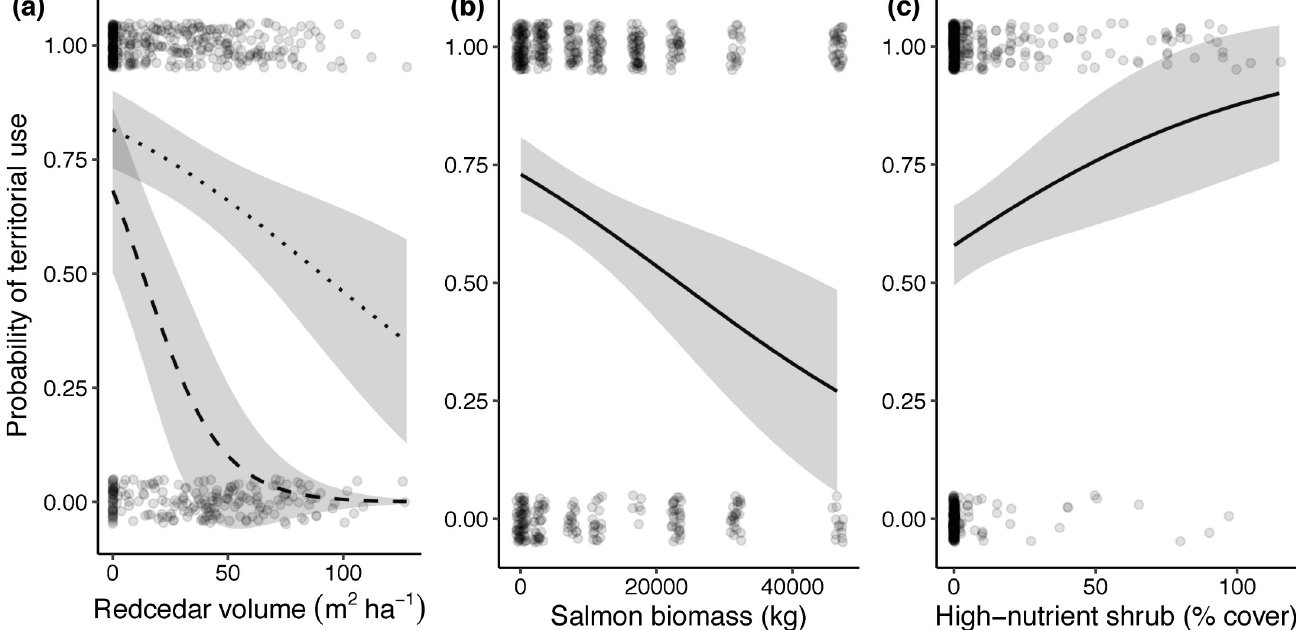
Fig 6. Resource selection probability plots for important predictor variables for the top model of probability of territorial use by male wrens. Lines are predicted probabilities of habitat being included in wren territories against (a) western redcedar stand basal area (m 2 ha -1 ) at high salmon biomass (47,000 kg, represented by the dashed line) and no salmon (0 kg, represented by the dotted line), (b) spawning salmon biomass (kg) at stream-level, and (c) percent high- nutrient shrub cover, with other variables set to their mean value. Bands are 95% confidence intervals and points are jittered to display the spread of data.